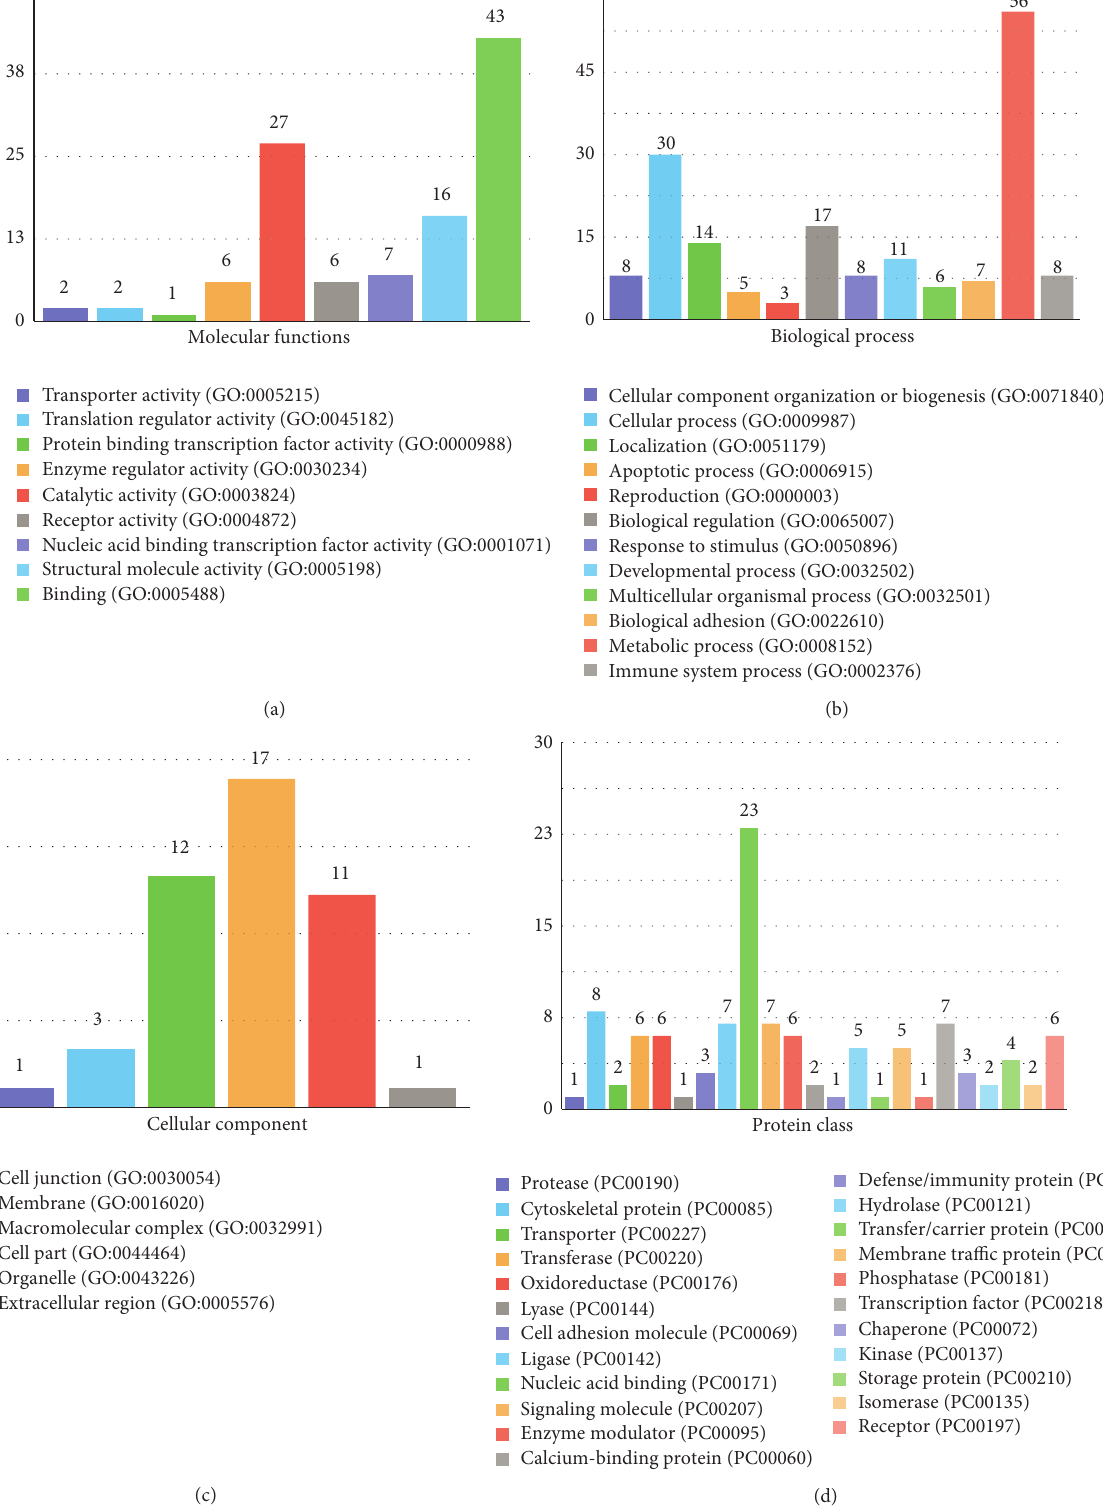
Figure 5: GO terms distribution in the molecular function (a), the biological process (b), the cellular components (c), and the protein class (d) for prenatal